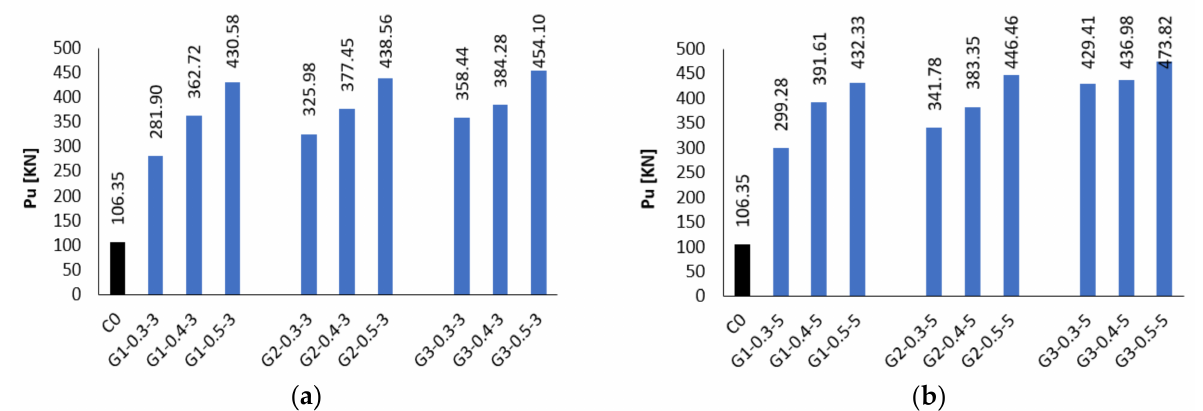
Figure 4. Max. ultimate load ( P u ) for all specimens. ( a ) Specimens (control& width ratio pb = 3), ( b ) Specimens (control& width ratio pb =